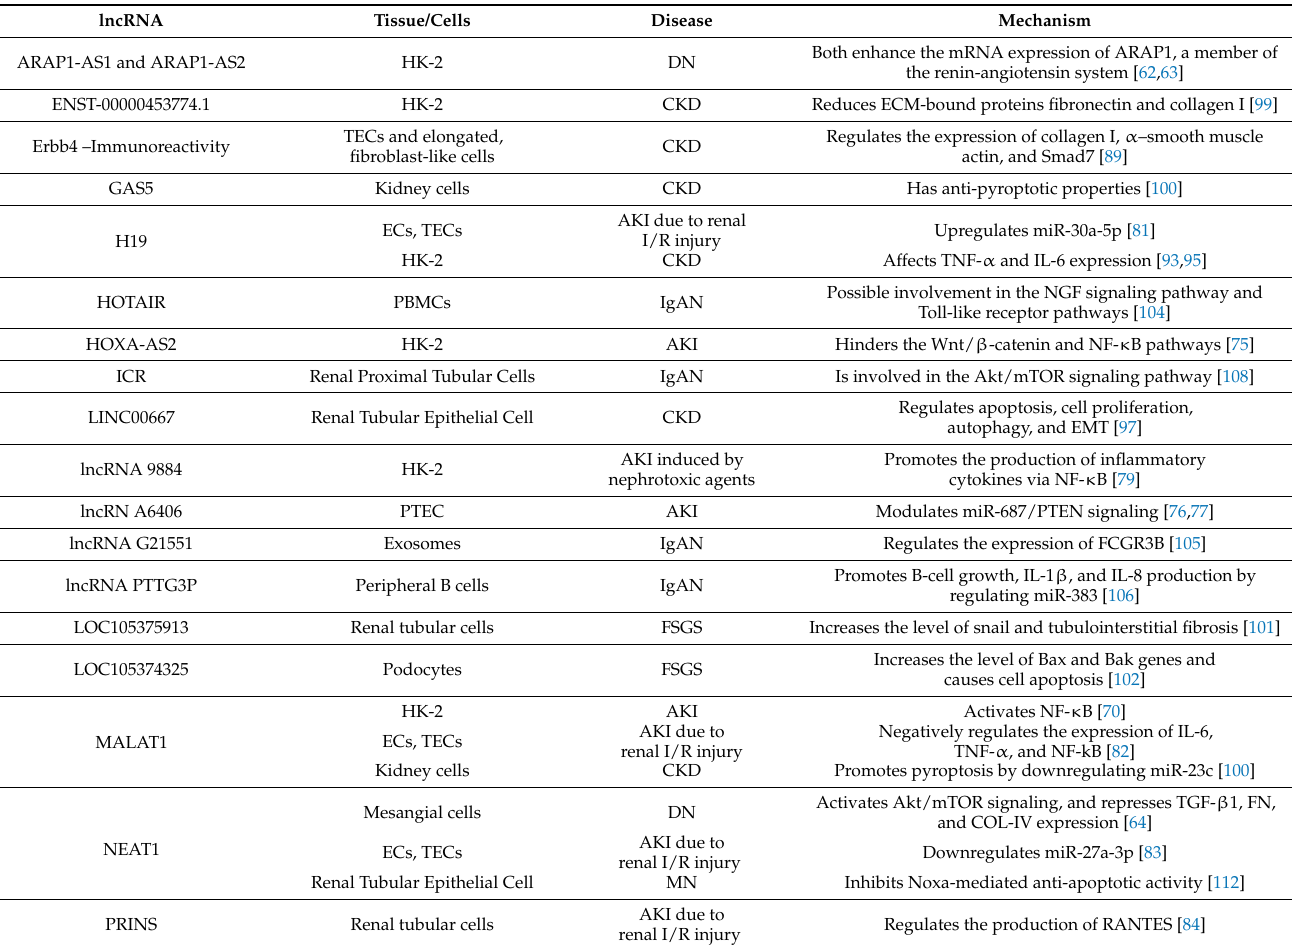
Table 1. Long non-coding RNAs in renal